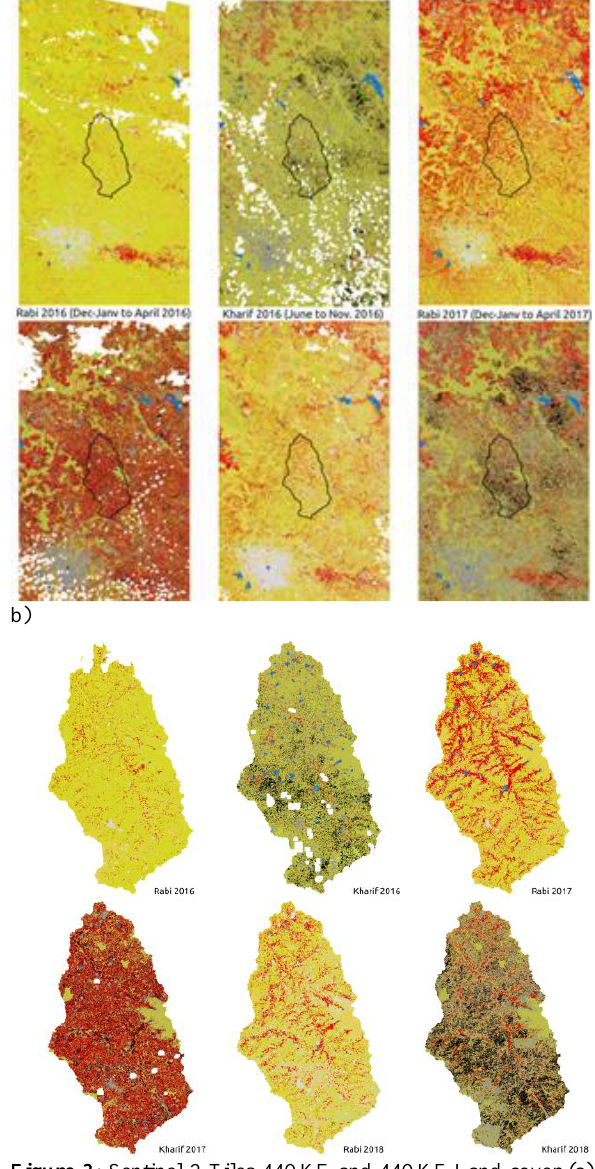
Figure 3 : Sentinel-2 Tiles 44QKE and 44QKF Land cover (a) and extracted for the Kudaliar watershed (b), produced for 6 seasons from the workflow presented in figure 2. The black polygon is the watershed where all the statistics have been computed. White areas are nodata where clouds were detected. Hyderabad city is in the south-west corner, rice command area of the Musi river is located at the east of the city. Karimnagar dam is in the north east corner. The situation changed in R2017, after the heavy rainfall of September. The surface water harvesting system is full, surface water have reached 3.4% of the catchment area, decreasing to 1.4% at the end of April 2017 with the cumulated effect of ground water recharge, evaporation and pumping for irrigation. Rice area reaches the highest extent : 22.73%, table 2,